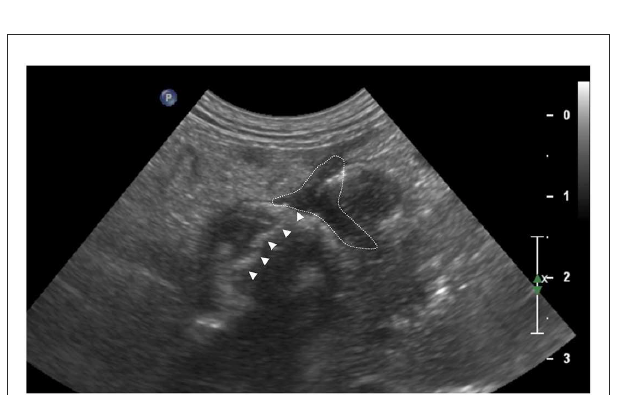
FIGURE2 Transverse sonogram of an intestinal dehiscence in a dog with latero-lateralis anastomosis obtained with a microconvex probe. Note the hypoechoic wall thickening with absent wall layering. Irregular hyperechoic linear interface (white arrows head) associated with dirty acoustic shadowing crossing the intestinal wall and reaching a fluid pocket (white dotted line) is also evident. The mesentery around the intestinal loop appears thickened and